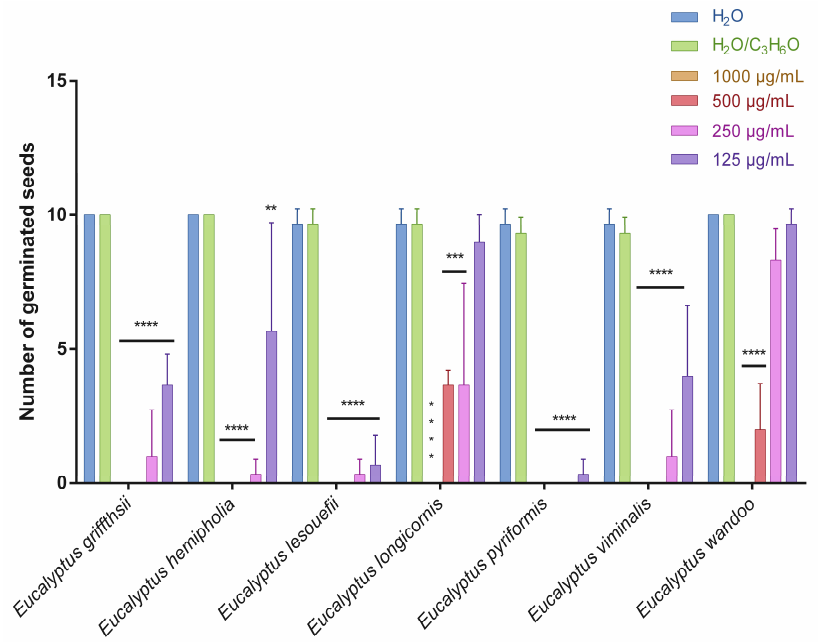
Figure 1. Number of germinated seeds of Sinapis arvensis seeds after treatment with different con- centrations (125–1000 µg/mL) of Eucalyptus essential oils measured 120 h after sowing. Results are the mean ± standard deviation ( n = 3) of three independent experiments. * p < 0.05; ** p < 0.01, *** p < 0.001, **** p < 0.0001 compared to control (ANOVA followed by Dunnett’s multiple comparison test).